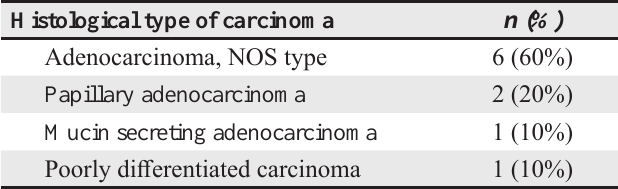
Table 2 : Histological variants of incidental carcinoma (N=10) Histological type of carcinoma